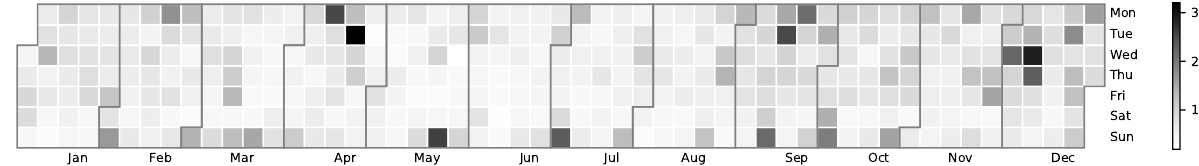
Figure 8. Calendar plot of mean absolute deviation from daily mean prices 2020 in